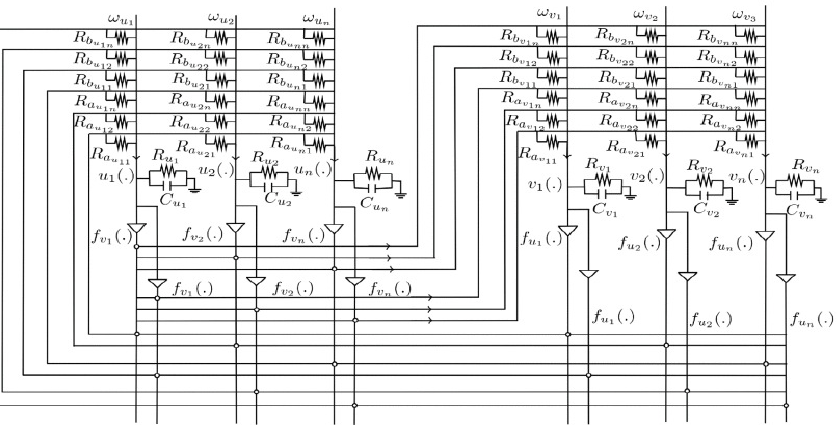
Figure 1. Circuit of memristor neural networks